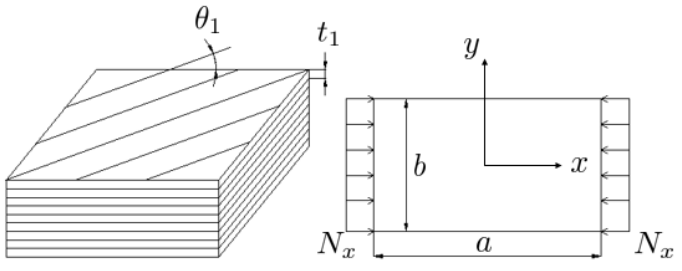
Figure 2. The geometry of a laminated plate with nine layers.